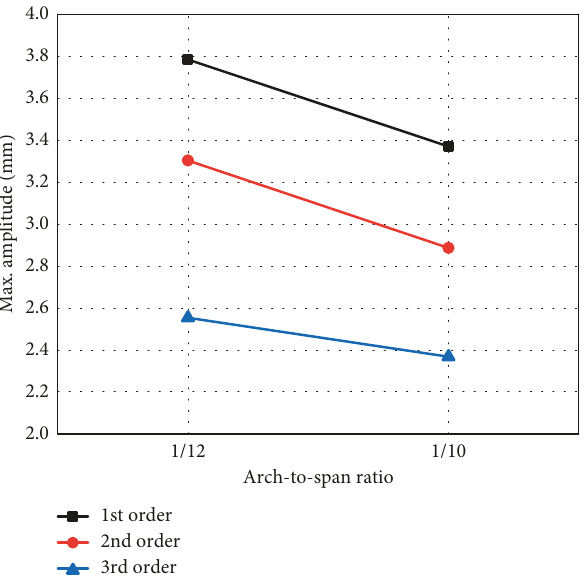
Figure 6: First three-order max. amplitude under different arch-to- span ratios when the pretension level is 3000N/m and hailstone diameter is 5.0cm.